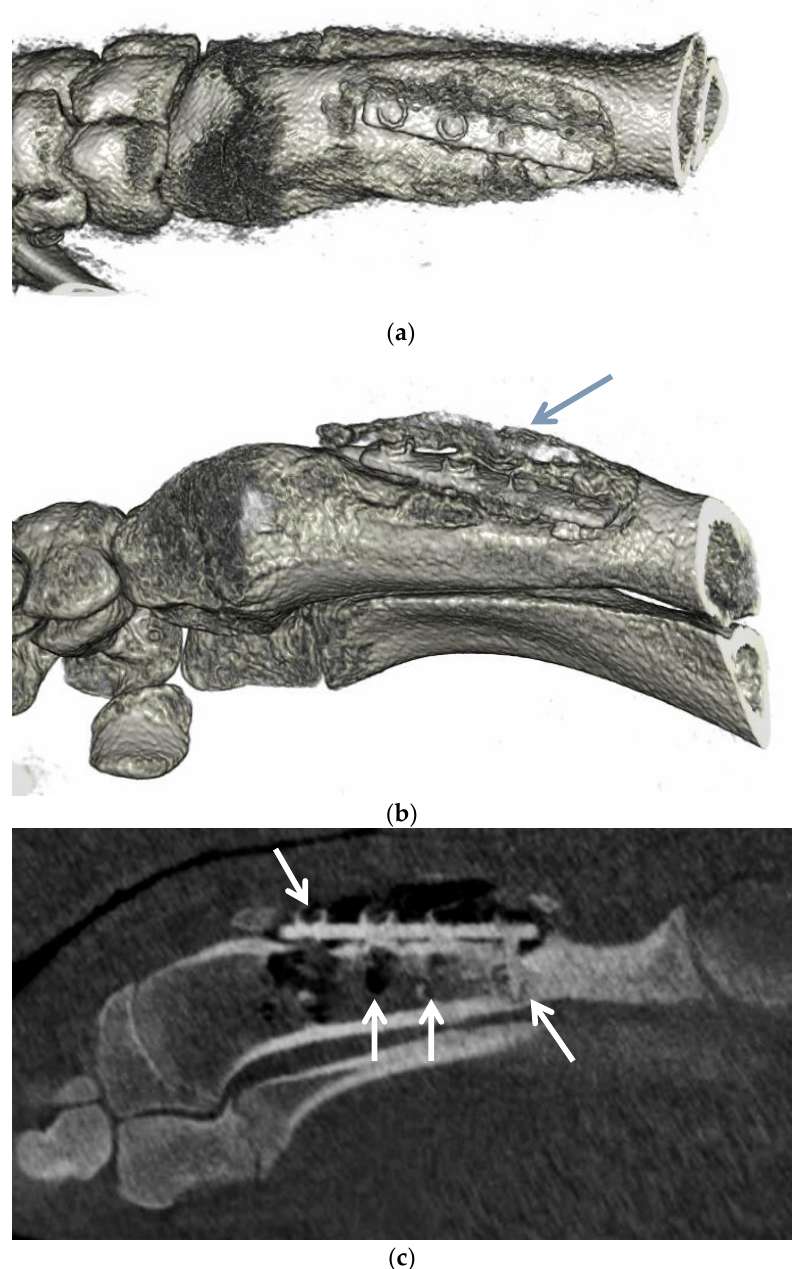
Figure 14. Micro-CT images recorded 3 months after surgery: ( a ) 3D reconstruction top view, ( b ) 3D reconstruction side view, and ( c ) Micro-CT side view.